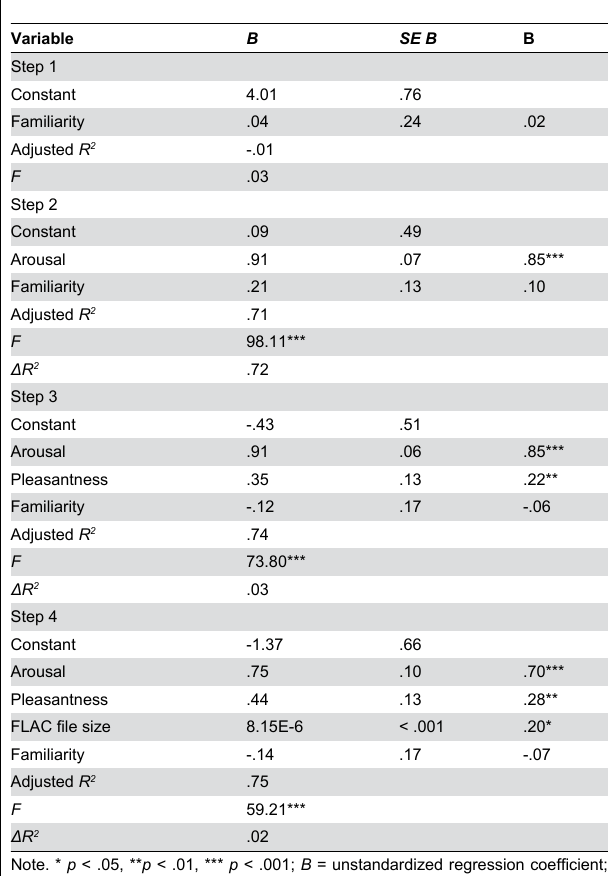
Table 12. Summary of linear stepwise regression analysis for seven variables predicting subjective complexity ratings of piano solo music (N = ≥ 85, n ≥ 84, n ≥ All males females